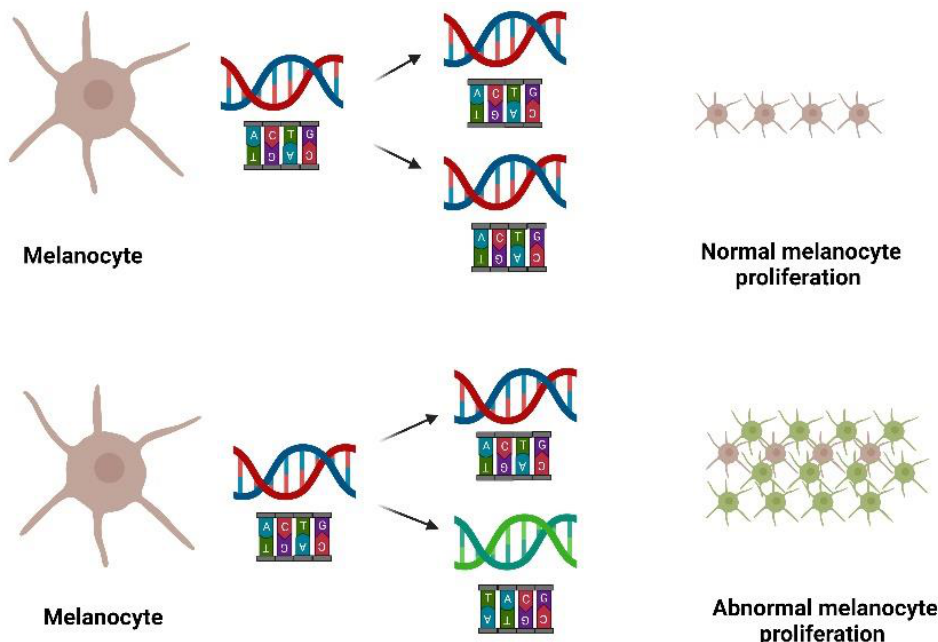
Figure 1. Melanoma can develop from mutations (caused by U.V. light for example; not shown) in melanocyte DNA (encoding for proto-oncogenes) that lead to dysregulated proliferation and spread of the mutated cells. Mutated DNA and melanoma cells are shown in green.